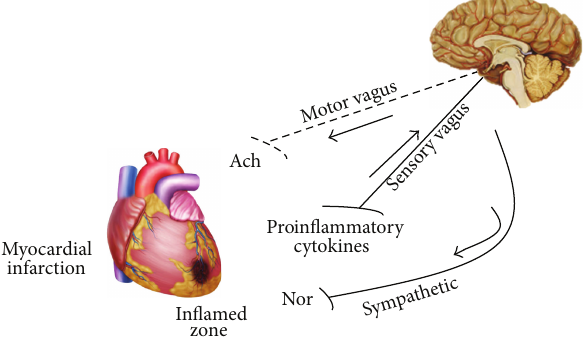
Figure 2: Blunted “inflammatory reflex” by vagal efferent function reduction after myocardial infarction (adapted from Tracey